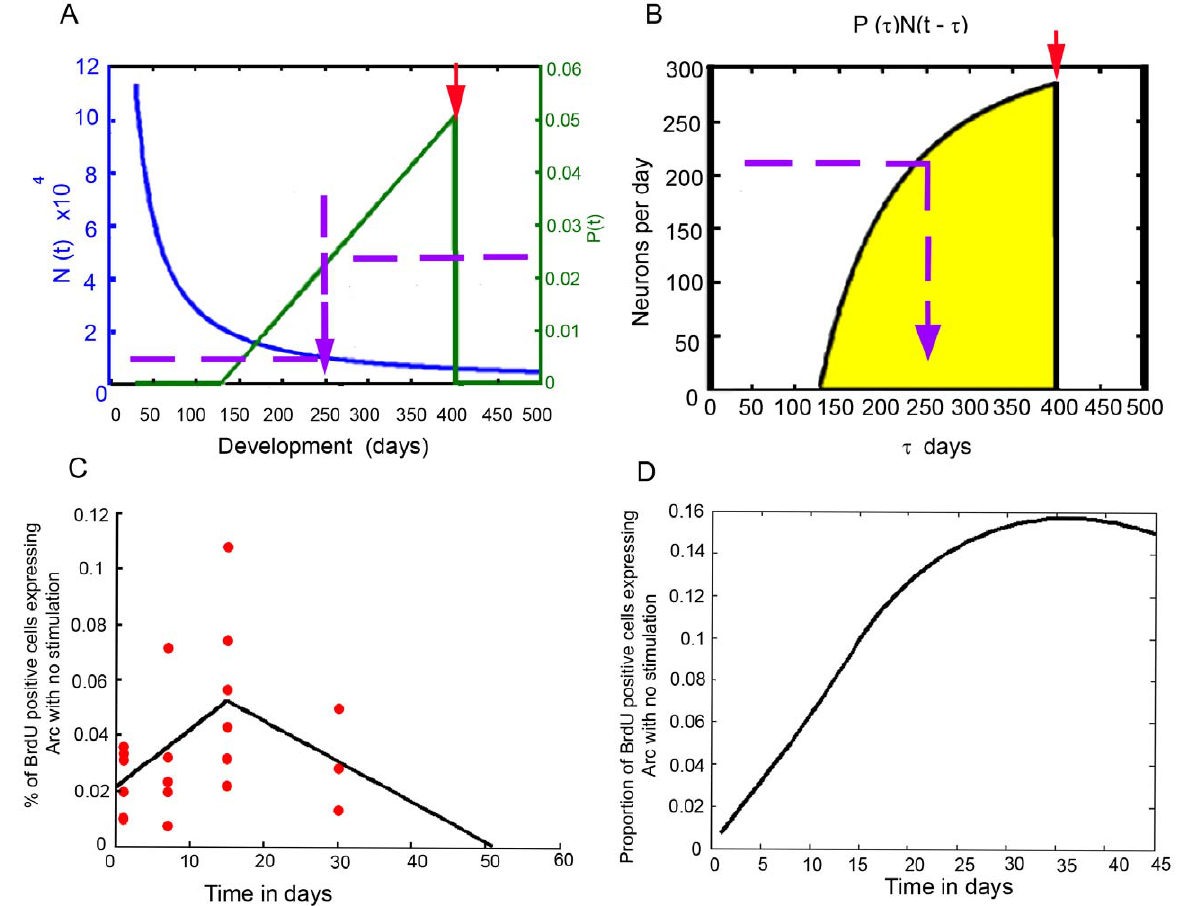
Figure 6. Illustration of the calculation procedure. A) As an example of our calculation that lead to the results found in Figure 6D, we can estimate the number of cells that contribute to the spatial exploration response at day 400 in the life of (red arrow), from cells born on day 250. We found , 11,000 new neurons that were born on day 250 and survive for at least 30 days; when we multiplied this by the proportion of neurons that responds to exploration at day 400 (2%), we calculated that , 220 cells respond to exploration (purple arrow in B); B) When all the new neurons are considered (area under the line in yellow) we have a total number of neurons that respond at day 400, from the cumulative number of new neurons at that time. C) To determine the background due to Arc expression during early development of new neurons, we calculated the probability of neurons to express Arc from 1 to 30 days, using 2 linear models. D) A similar convolution as the one used for our previous calculation was done to estimate the number of adult-born neurons found from 1 to 30 days PBI (Figure 5 C). Note that the maximum proportion of neurons that express Arc with no stimulation is , 0.16%; for comparison, cage control animals present 0.31% of cells expressing Arc with no previous stimulation (Figure 5 A), and this represents , 10% of the granular cells expressing Arc after spatial exploration.